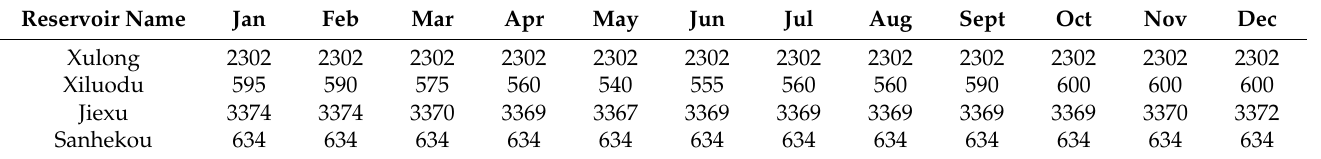
Table 4. Reservoir operating water level (altitude,